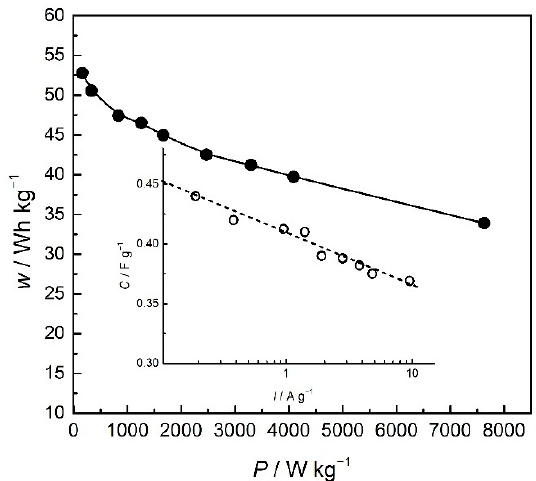
Figure 9. The dependence of specific power, P , and specific energy, w , of PANI vs. SCE on the discharge current.